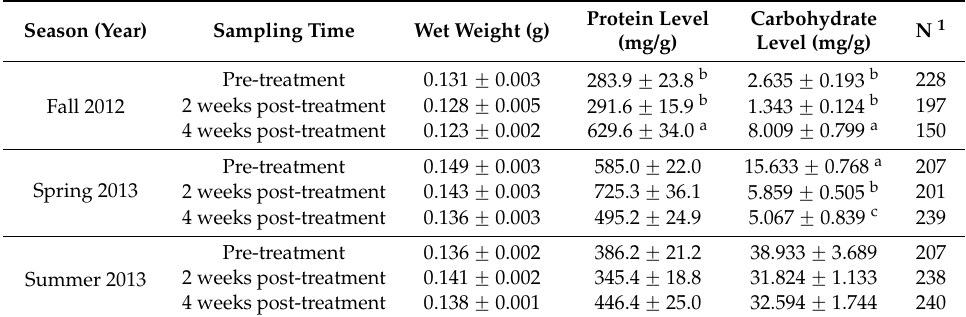
Table 2. Mean ( ˘ standard error) wet weight and macromolecule levels combined across four treatments (three pesticides and a control) for worker honey bees tested in fall, spring, and summer.